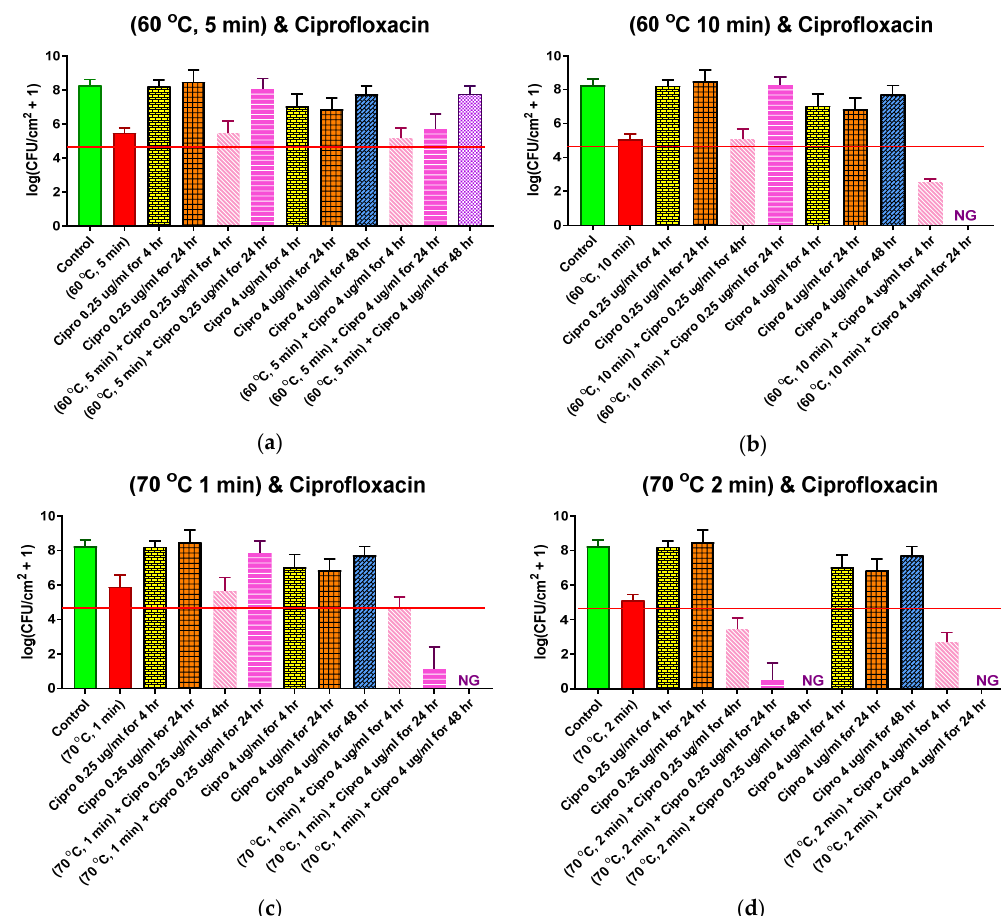
Figure 5. Combined ciprofloxacin and thermal shock effect on the P. aeruginosa drip flow reactor biofilm population. Each panel shows results for the thermal shock and antibiotic exposure indicated. Red horizontal lines show the critical population density below which thermal shocked bacterial biofilms are not viable. Error bars indicate standard deviation for at least six slides from three different dishes.